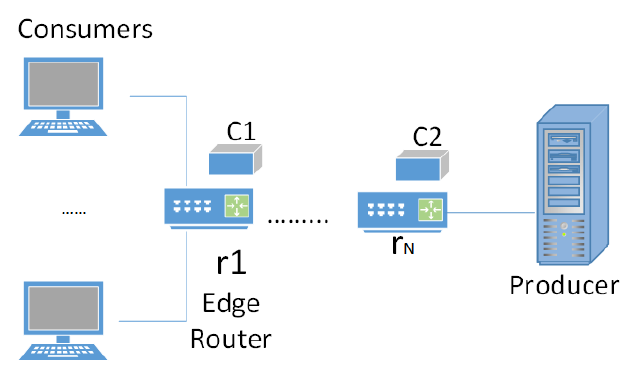
Figure 2. Network